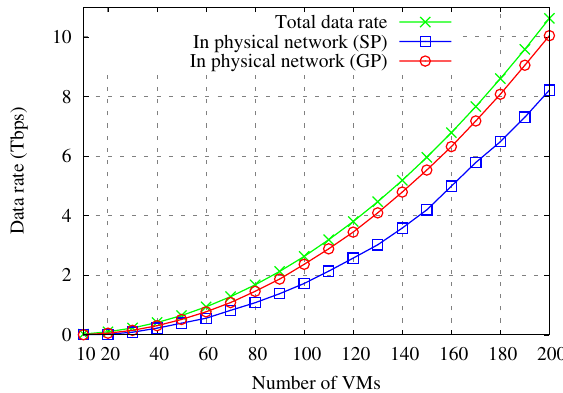
Figure 9. Data rate in the physical network with respect to number of